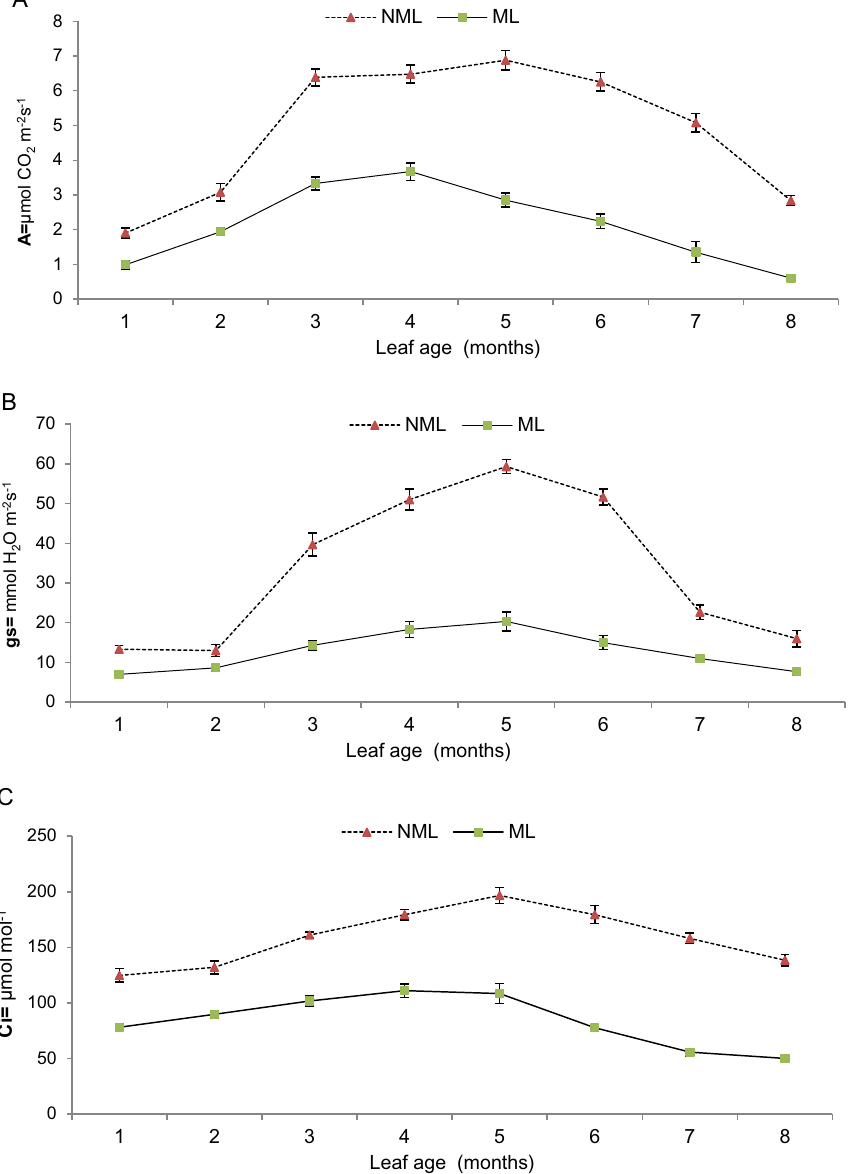
Figure 6. Photosynthetic activity of non-mined and mined leaves in leaf-age 1–8 months ( A ) net assimilation rate (An) ( B ) stomatal conductance (gs) ( C ) sub-stomatal conductance/intercellular CO 2 concentration (Ci).